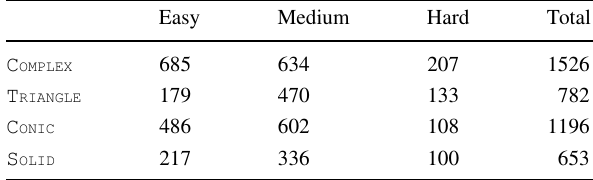
Table 4 Summary of exercises in the